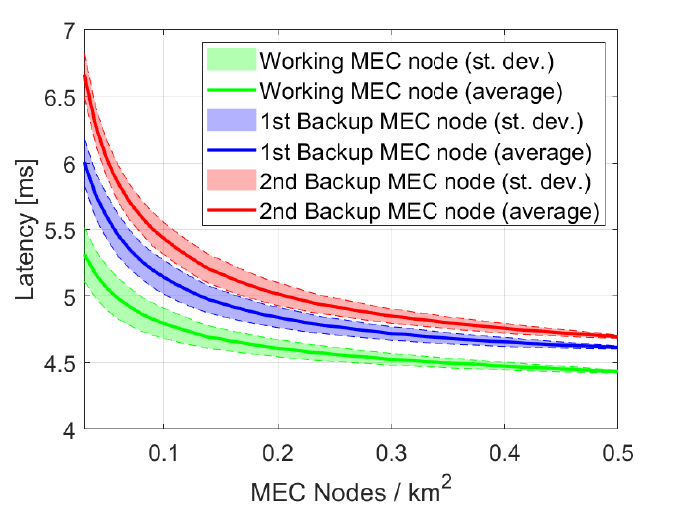
Figure 8. Average delays and standard deviations for working and backup MEC